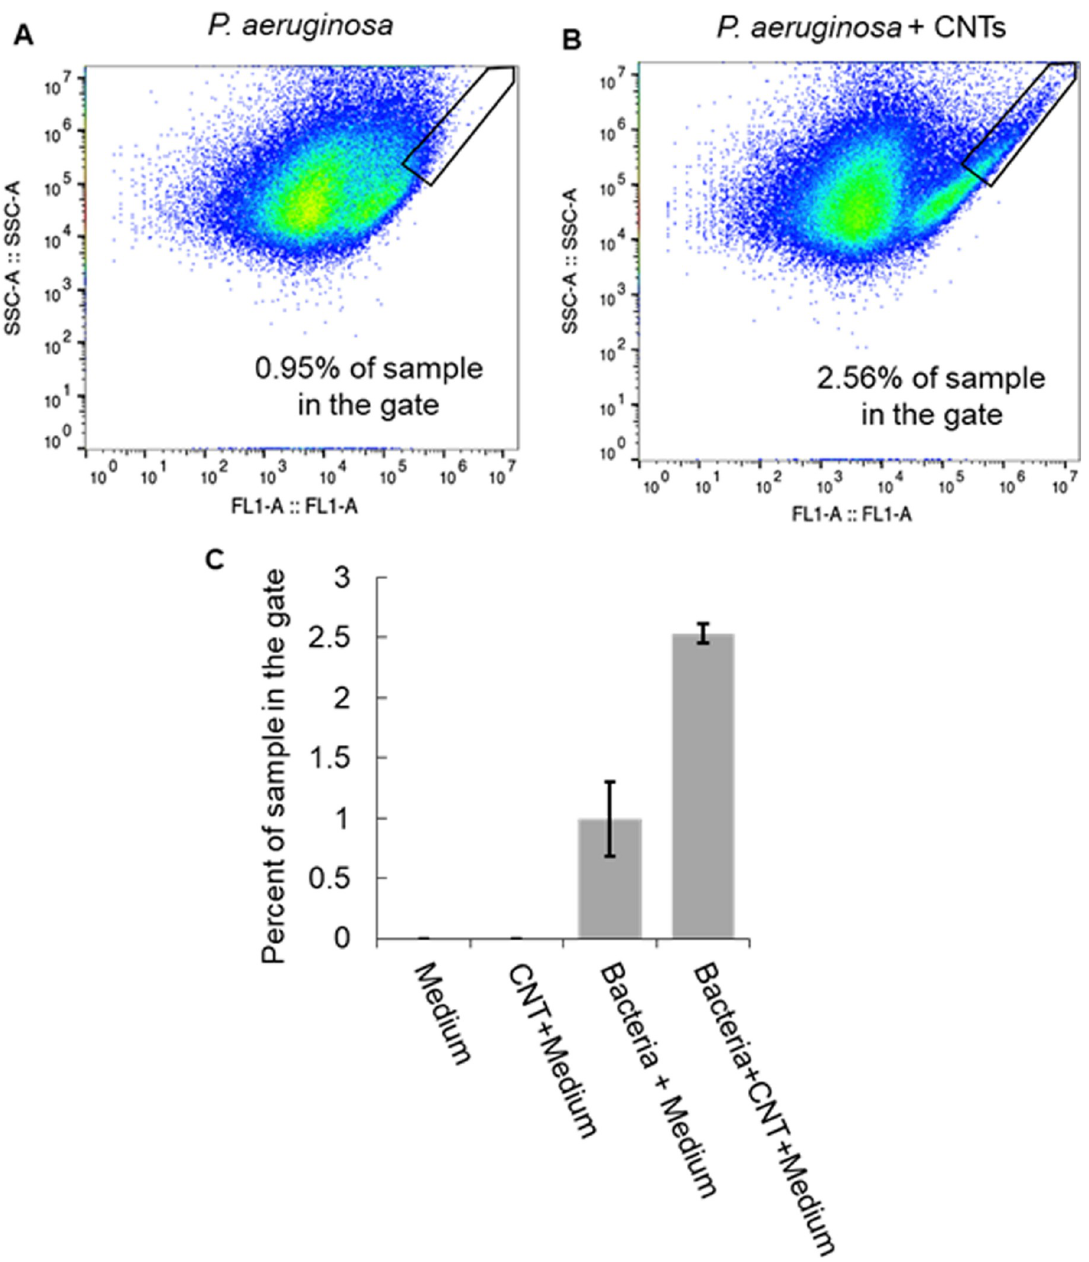
Fig 3. Flow cytometry is used to measure the percentage of each subculture containing large aggregates. Examples of data from flow cytometry containing (A) P . aeruginosa only and (B) P . aeruginosa with MWCNTs. The vertical axes, labeled SSC-A, give the side-scatter area, and the horizontal axes, labeled FL1-A, give the GFP fluorescence area. Black lines define a gate with both high side-scatter and high fluorescence areas. This region is the gate we use to measure the number of very large fluorescent objects in the sample. (C) For three separate sets of samples and flow cytometry trials (N = 3), we find that bacterial subcultures containing MWCNTs have, on average, more than twice as many large aggregates than do MWCNT-free bacterial subcultures. No large aggregates were found in the sterile medium or the sterile medium containing MWCNTs. Error bars are the standard error of the